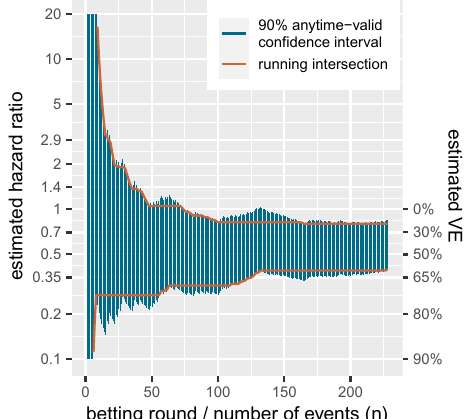
Figure 3. 90%-confidence sequence for a random ordering of the 83 events in the vaccine group and 145 events in placebo from the CureVac AG (2021) trial. Note that the y-axis is on the log scale.